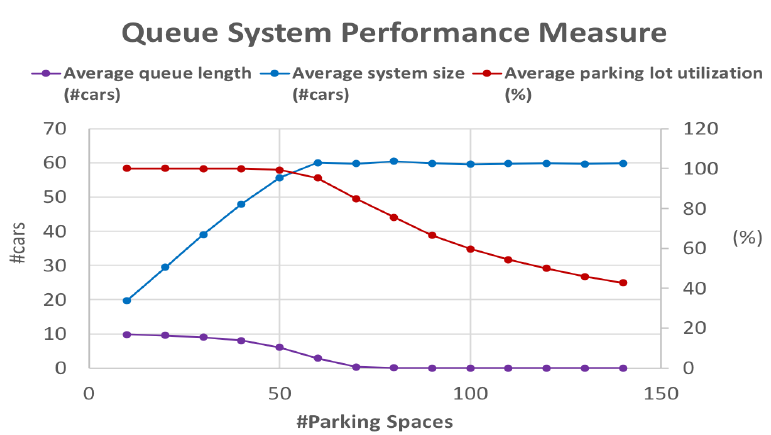
Figure 23. Relationship between the variations of the performance measures, average queue length, average system time, and average parking lot utilization, for a parking lot model with λ = 20 cars/h, µ = 0.333 cars/h, QC = 10 cars, and #parking spaces = c.